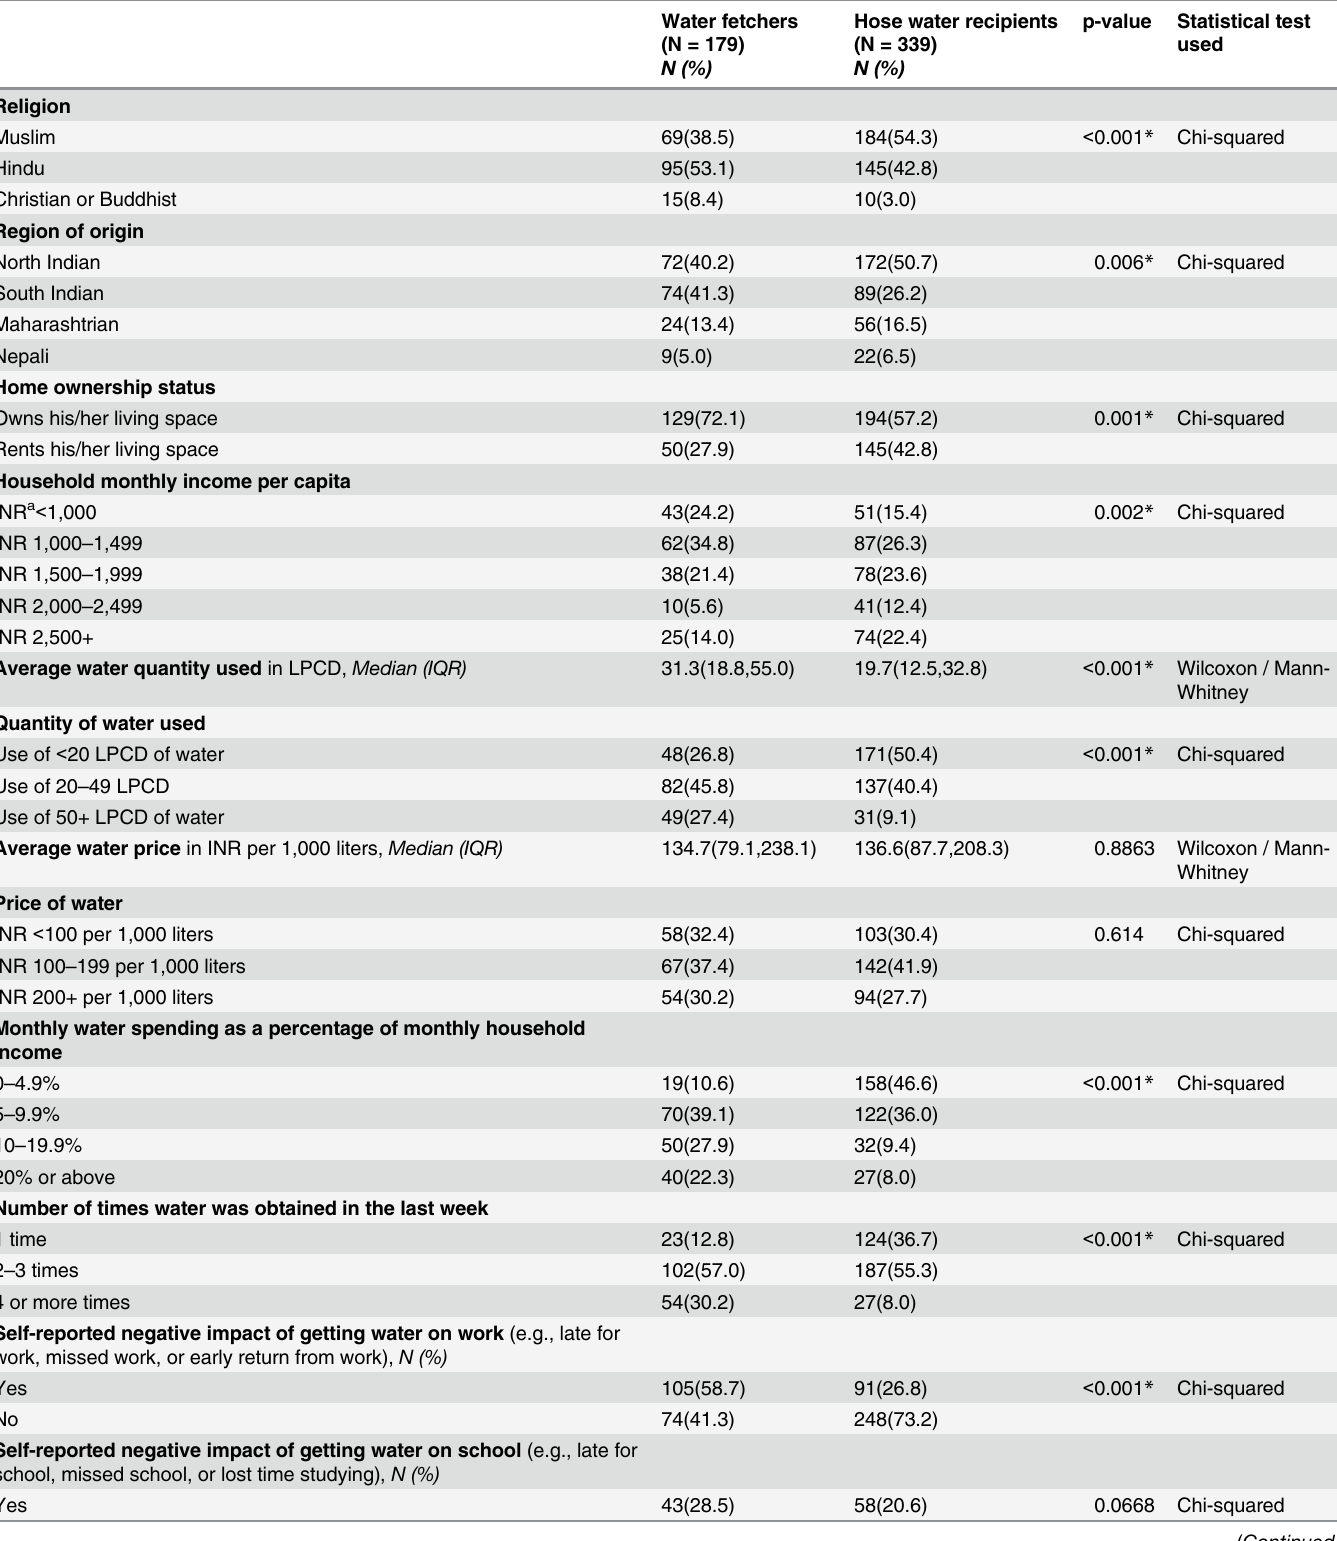
Table 3. Differences in water indicators based on mode of water